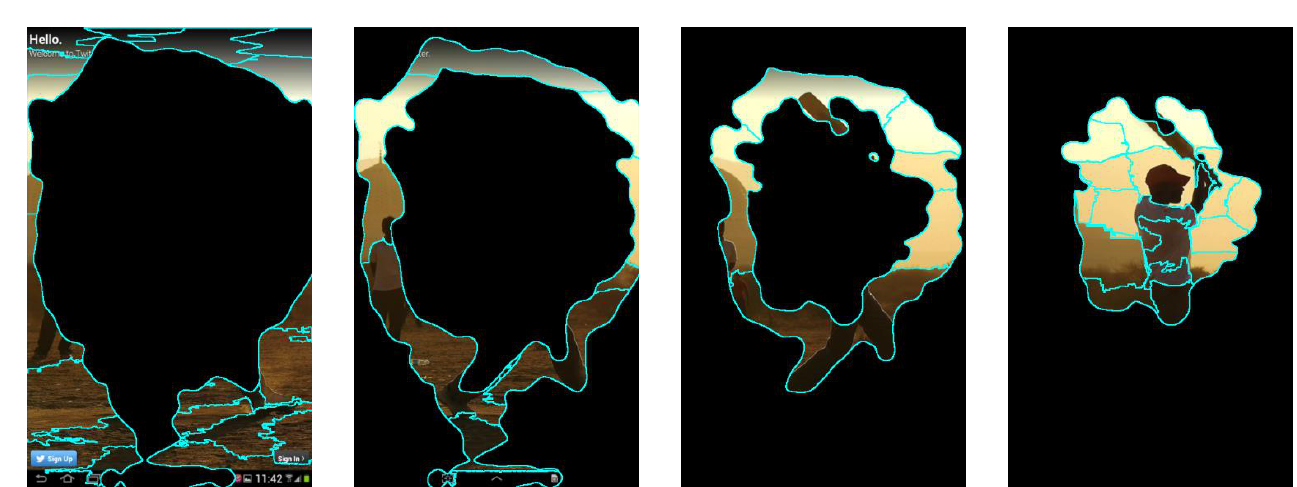
Figure 10. CovSal cluster divided by the proposed superpixel method based on color. Table 2. Initial position search algorithm for superpixels in a compressed CovSal image.